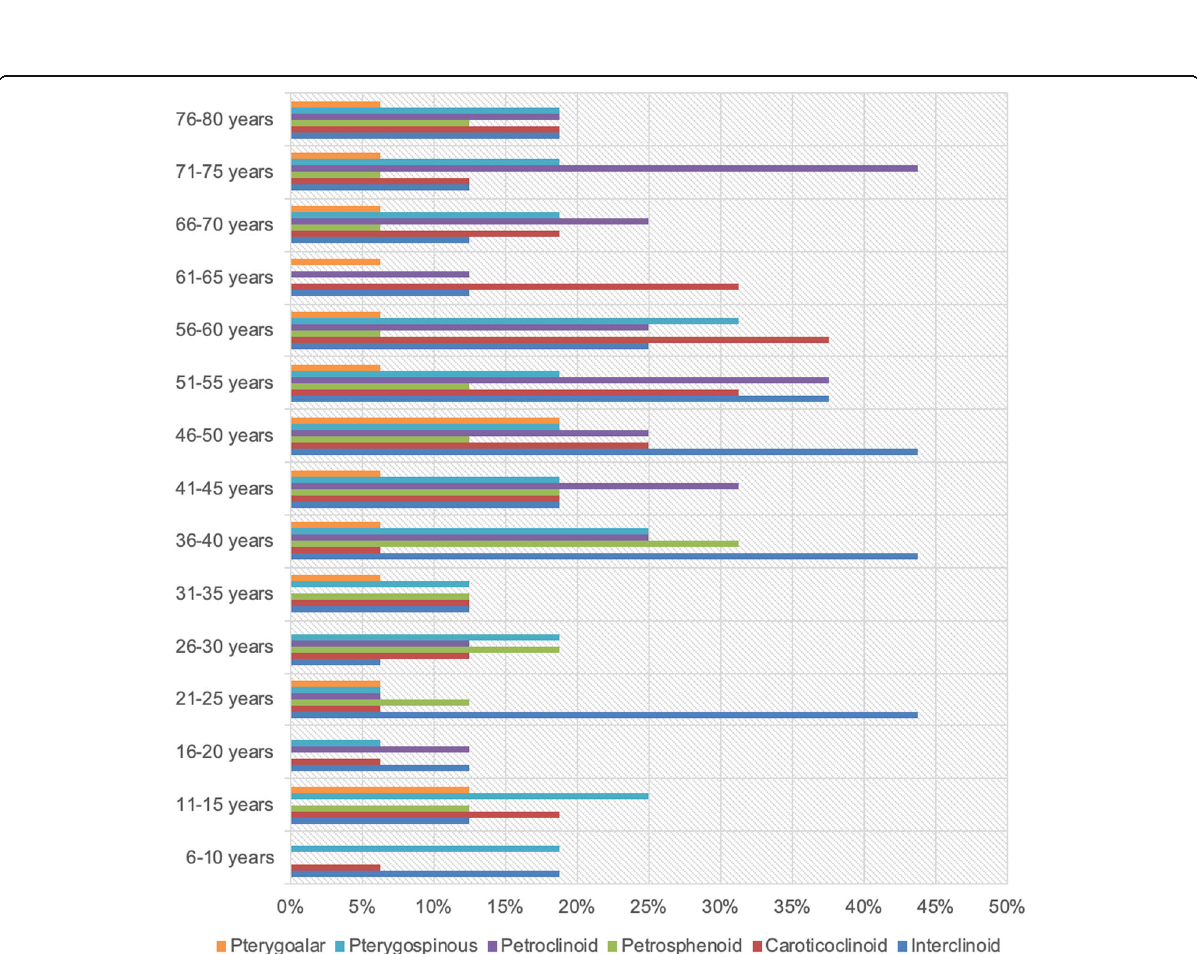
Fig. 5 Ligament ossification by type and age